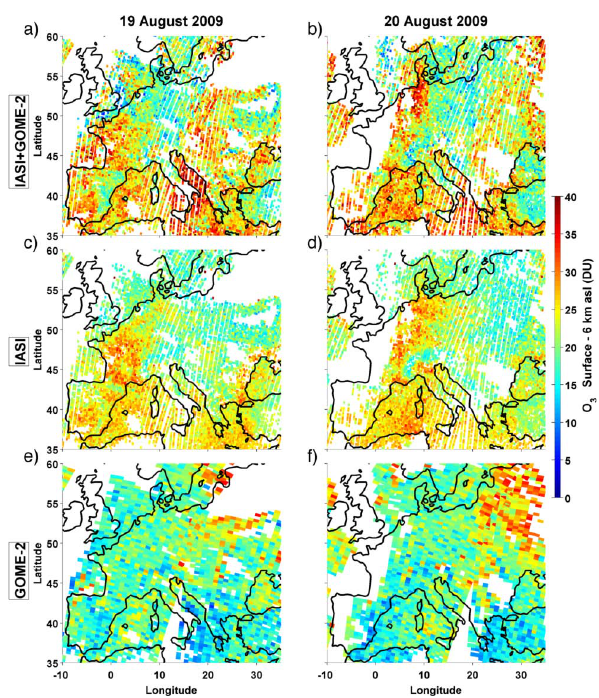
Fig. 9. Ozone observations (DU) in the lower troposphere partial column (LT, up to 6km a.s.l.) over Europe on 19 (left) and 20 (right) August 2009 from ( a and b ) IASI+GOME-2, ( c and d ) IASI only and ( e and f ) GOME-2 only